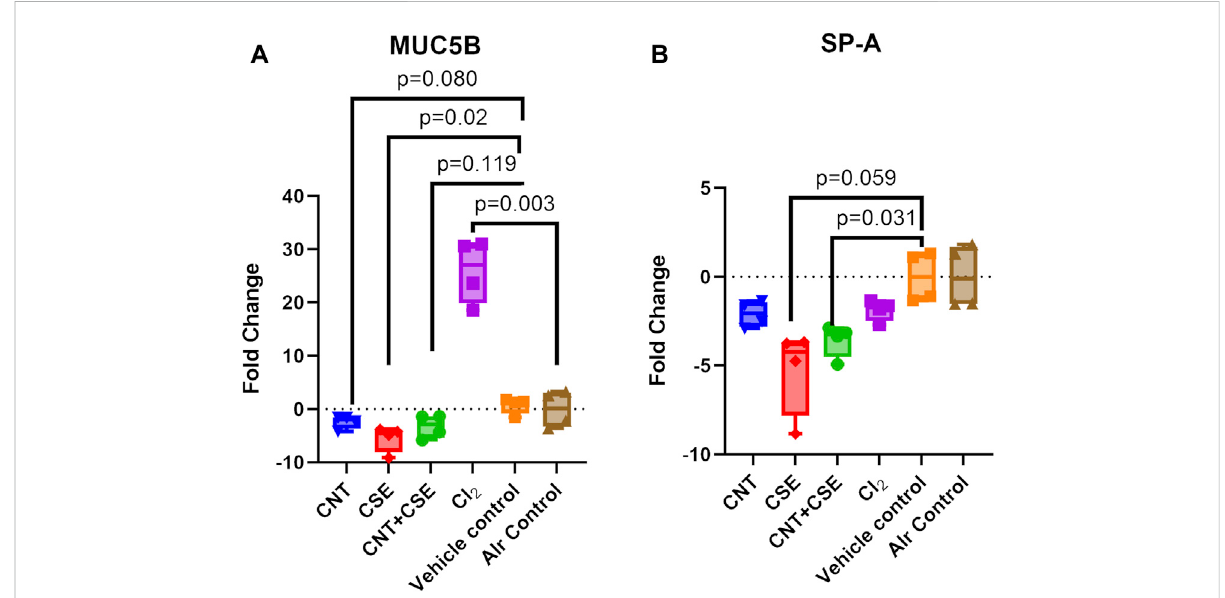
FIGURE 2 Expression of lung mucosal defense proteins [MUC5B (A) and SP-A (B) ] in mice subjected to different respiratory exposure regimens for CNT, CSE, CNT + CSE, and Cl 2 , as described in the Figure 1 legend. Transcriptional expression of the target proteins was measured using gene-speci fi c qRT-PCR. Statistical differences are represented by p -values.